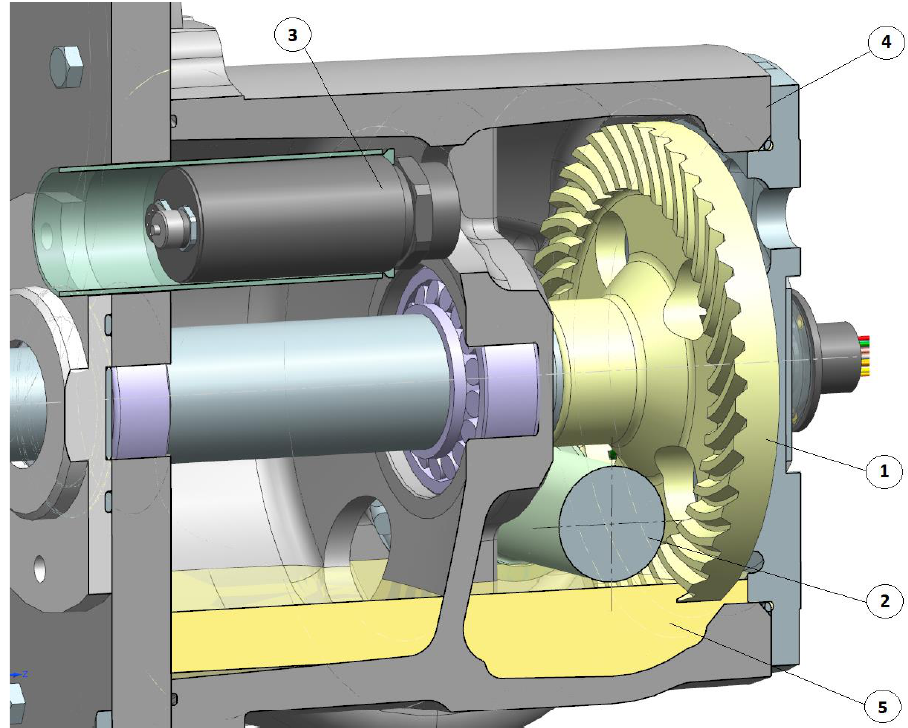
Figure 12. Location of the miniature thermal imaging camera Optris Xi80 in the body of closed gear; 1 — face gear, 2 — worm, 3 — thermal imaging camera, 4 — gear casing, and 5 — oil.